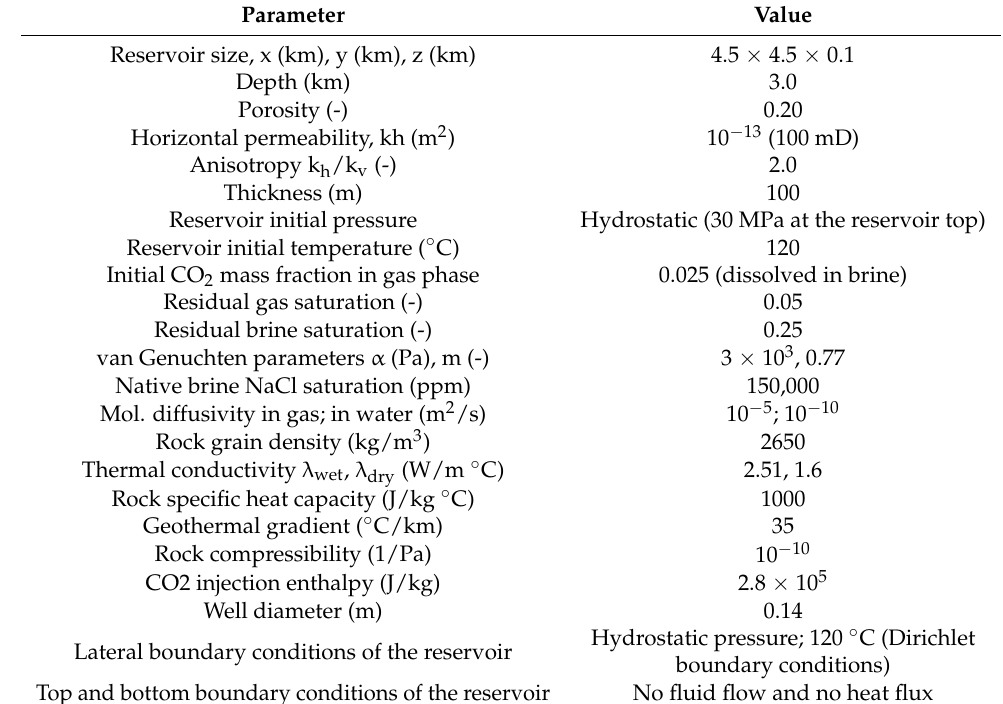
Table 1. Parameters for the base-case reservoir